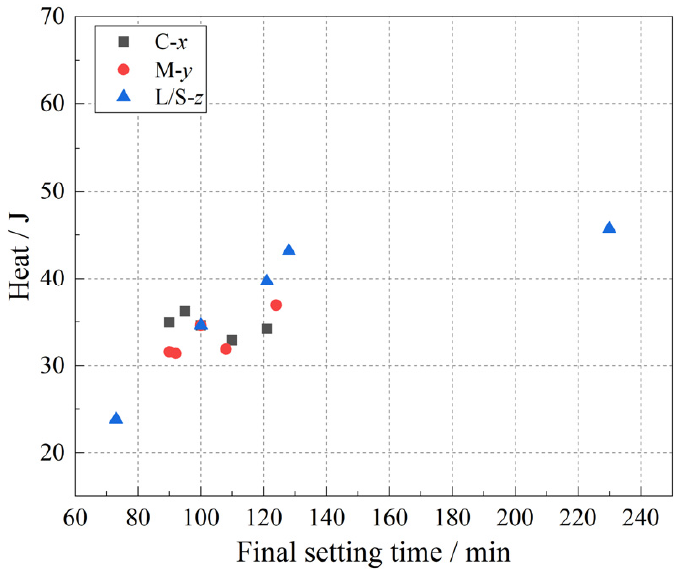
Figure 8. Heat released as a function of final setting time.